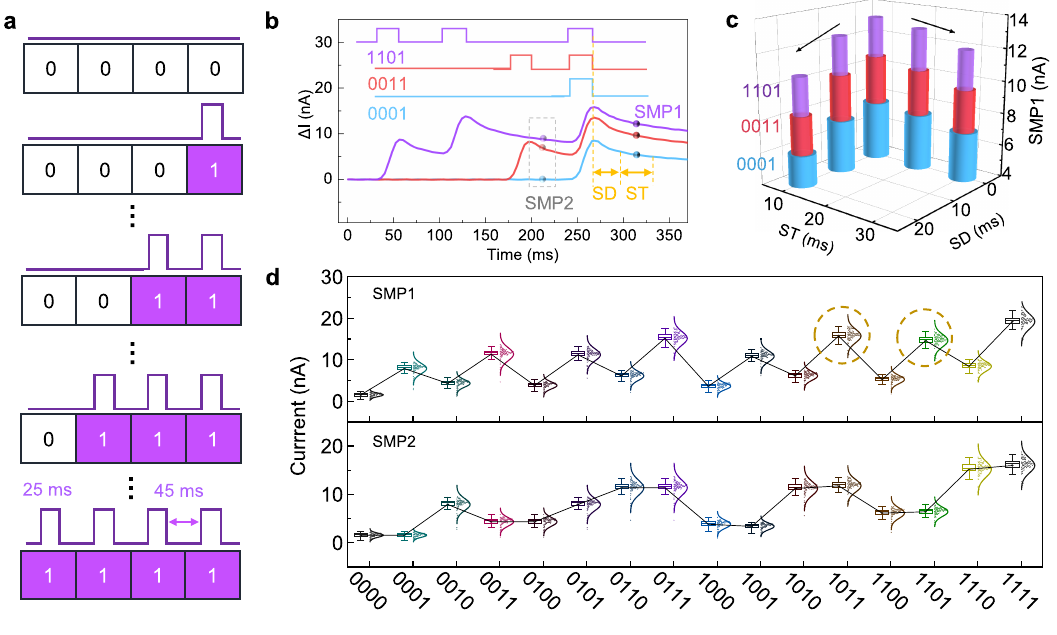
Fig.3|Nonlinearmappingof4-bitinputsbasedonthea-GaO x reservoir.a 4-bit inputs in the form of a binarized number and equivalent light pulses from “ 0000 ” to “ 1111 ” . The pulse width is 25ms and pulse interval is 45ms here. b I-t